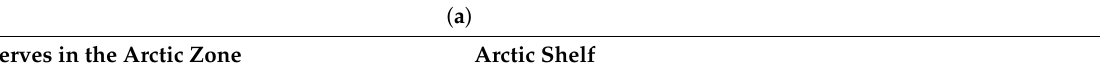
Table 4. ( a ) Data on hydrocarbon reserves (oil, gas, and condensate) in the AZRF current. ( b ) Prospective projects for development in the Arctic region.